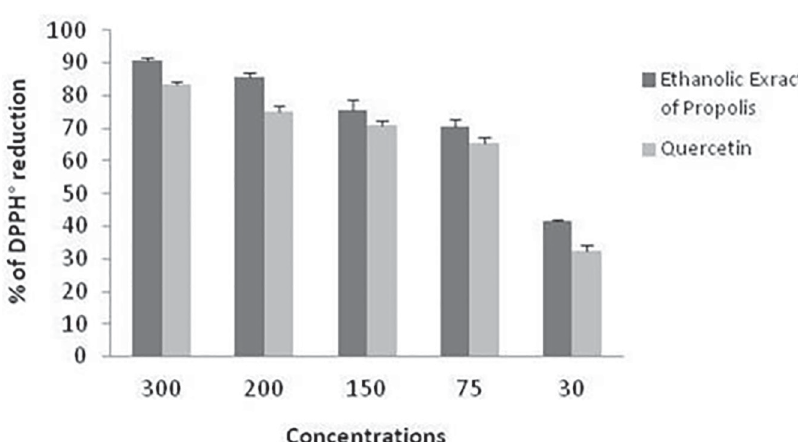
FIGURE 3 - Scavenging effect of the Algerian ethanolic extract of propolis (EEP) vs. quercetin against DPPH free radicals. Each value is expressed as mean ± standard deviation of three independent experiments. TABLE I - Effect of administering the ethanolic extract of propolis on the body and lung weight and ratio of lung to body weight in rats